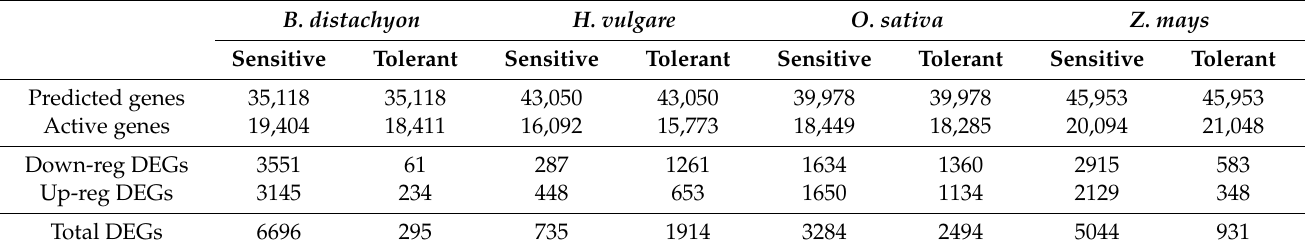
Table 2. Numbers of predicted genes in the reference assembly for each species, of active genes and of down- and up-regulated DEGs for each experiment. B. distachyon H.